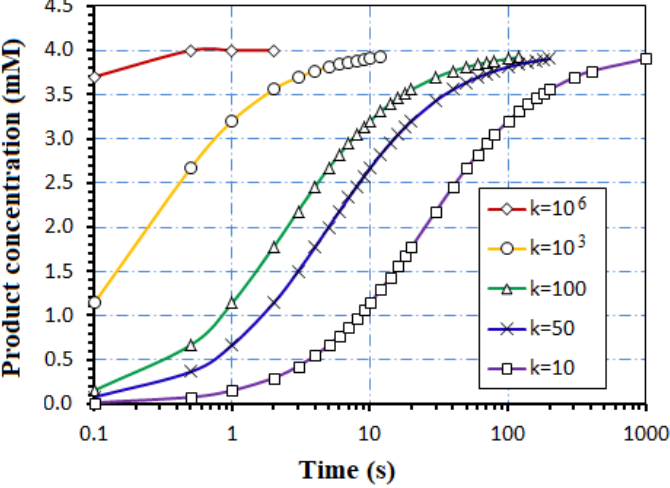
Figure 6. The simulated time dependence of the H + product, for AcH biosensor, where k is the reac- tion constant expressed in mili-mol − 1 s − 1 . reaction constant expressed in mili-mol − 1 s − 1